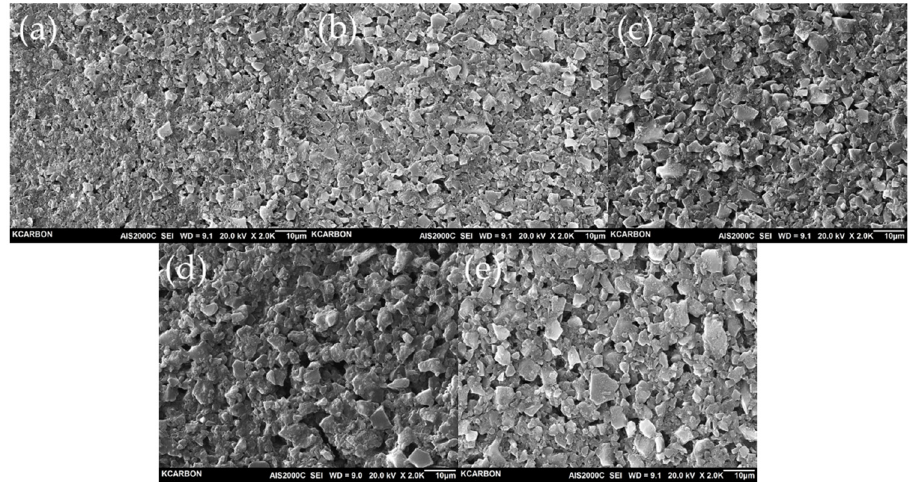
Figure 5. SEM images of the activated carbon electrodes ( a ) PB-H-9-3, ( b ) PB-H-9-4, ( c ) PB-H-9-5, ( d ) PB-H-9-6, and ( e ) YP-50F. ( d ) PB-H-9-6, and ( e )